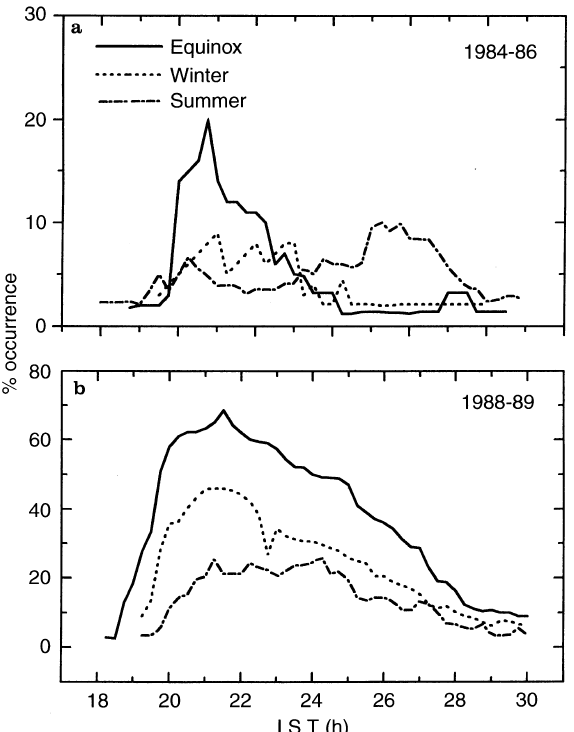
Fig. 1a, b. Average seasonal variation of percentage occurrence of scintillations during a 1984–1986 (low solar-activity period) and b 1988–1989 (high solar-activity period)